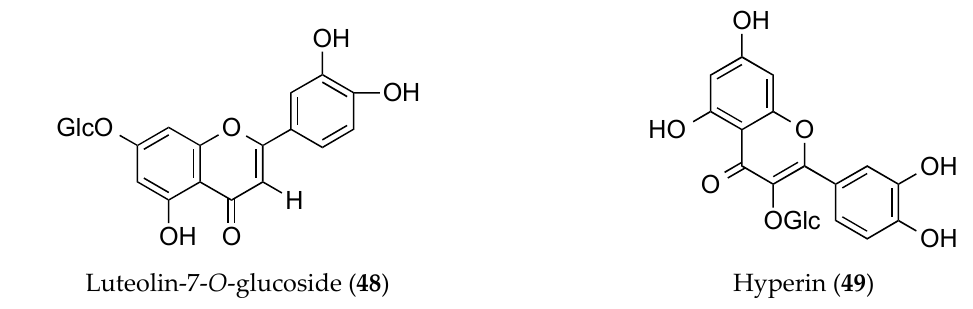
Figure 4. Flavonoids from the genus of Ophiorrhiza. *Glc = glucose molecule.